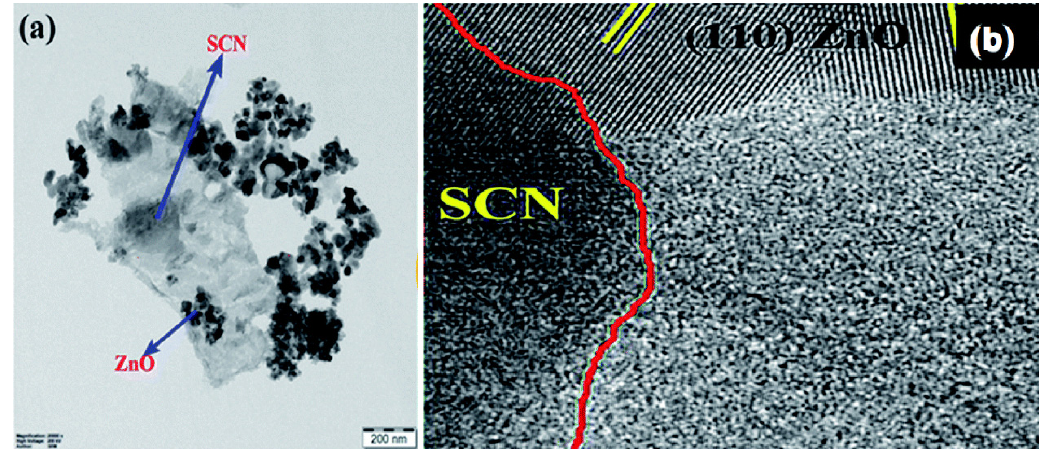
Figure 9. Images of ZnO/S-doped g-C 3 N 4 material ( a ) TEM, ( b ) HRTEM [76].